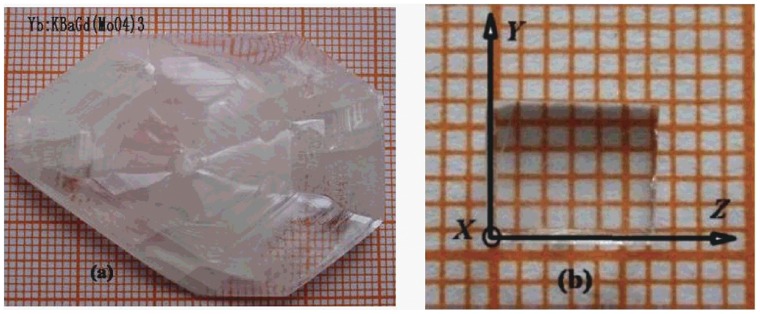
Picture of (a) Yb3+:KBaGd(MoO4)3 crystal, (b) polished sample cut from the crystal.